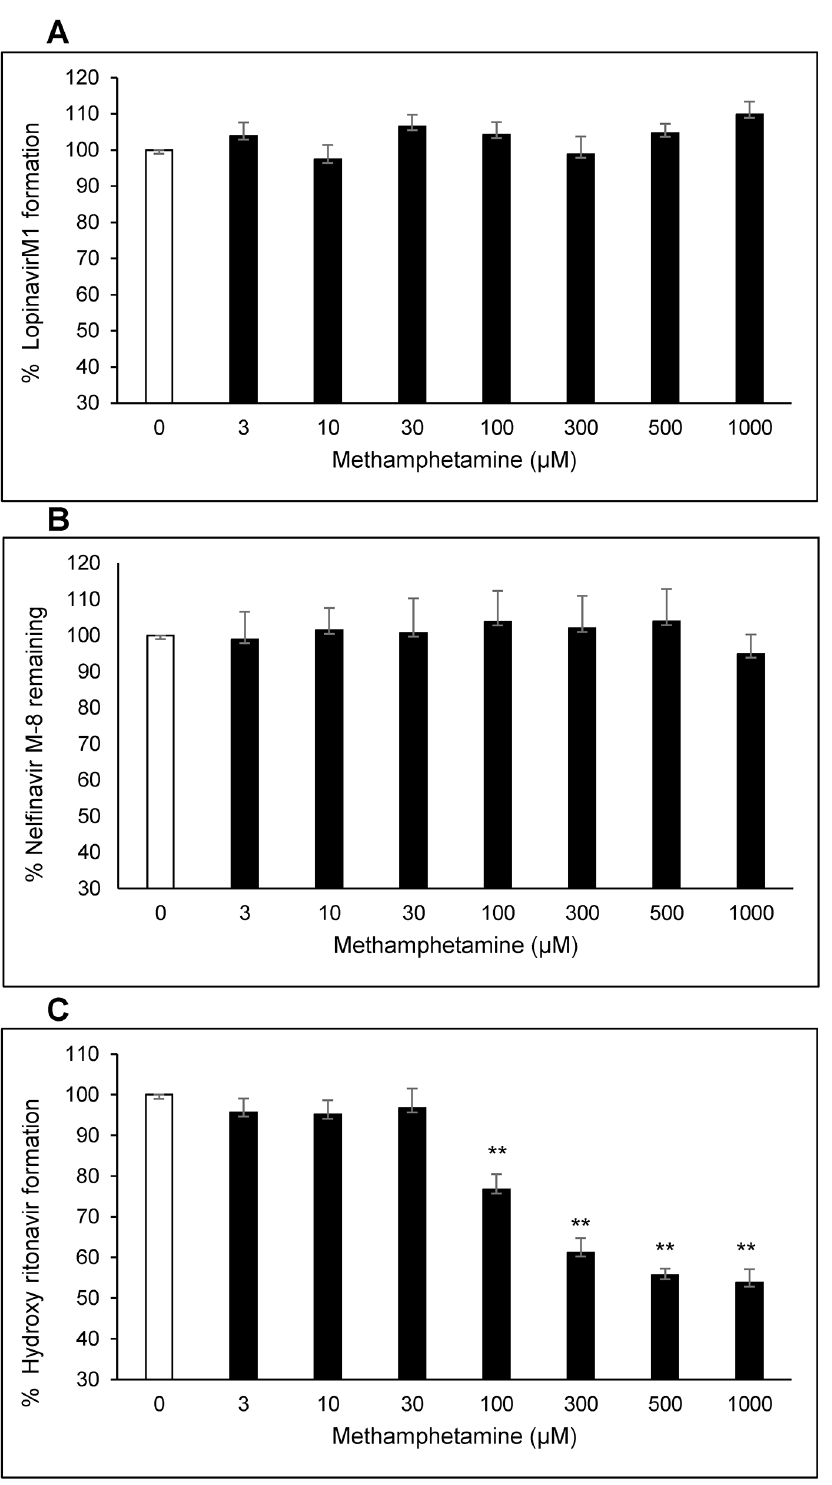
Fig 4. Effect of methamphetamine on metabolism of PIs in CYP3A4 human liver microsomes. Effect of methamphetamine on (A) lopinavir M1 formation from lopinavir, (B) nelfinavir M8 degradation and, (C) hydroxy ritonavir formation from ritonavir. One way ANOVA with Dunnet ’ s post-hoc test was employed to calculate the statistical significance and ** denotes p-value < 0.01.